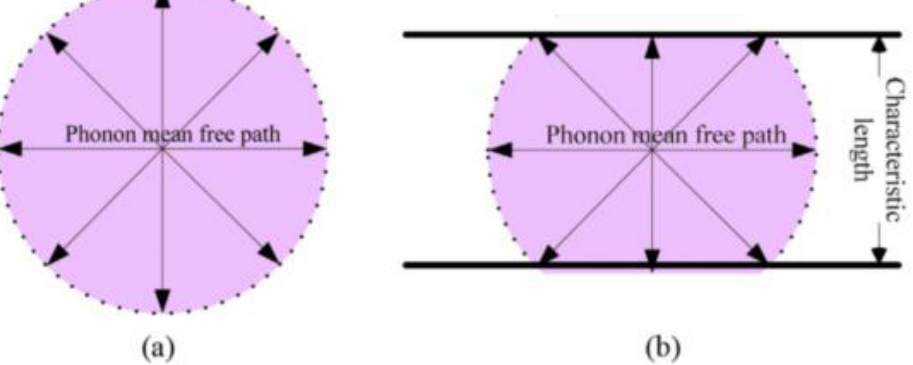
Figure 8. Diagram of size effect of solid thermal conductivity: ( a ) free space; ( b ) nanoscale heat transfer in a limited space.